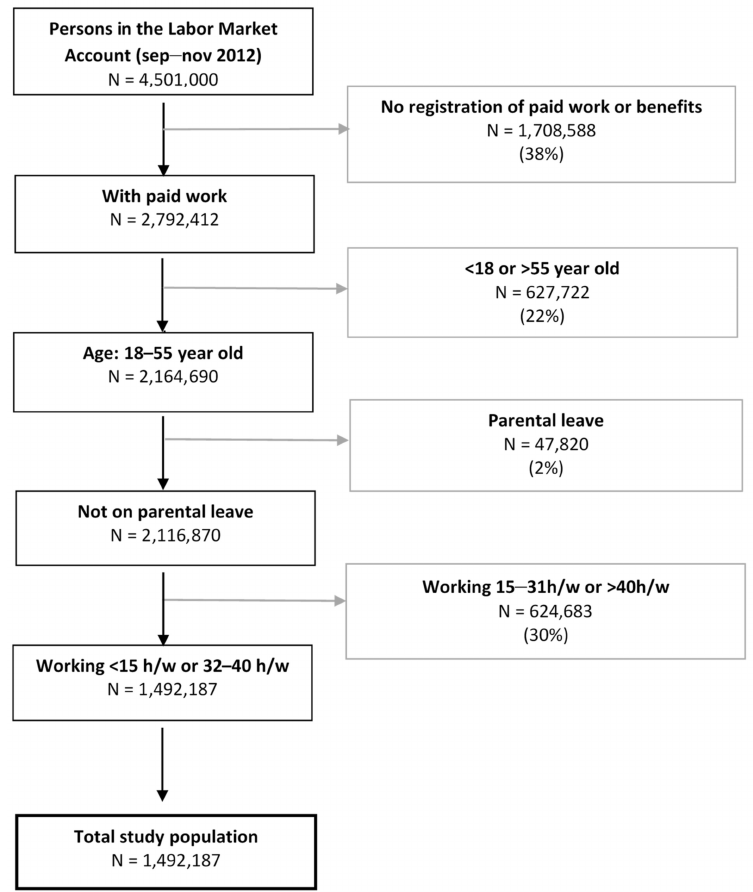
Figure 1. Flowchart of the study population. h/w = hours per